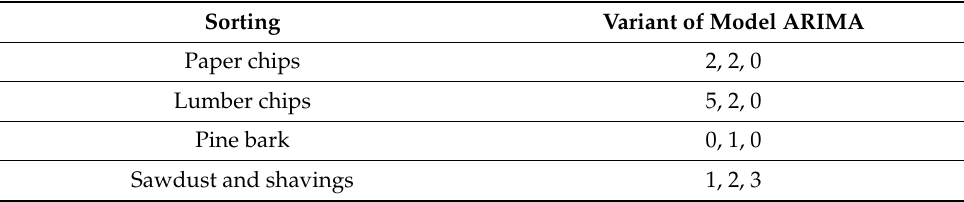
Table 3. Selection of ARIMA variants for paper chips, lumber chips, pine bark, sawdust and shavings.